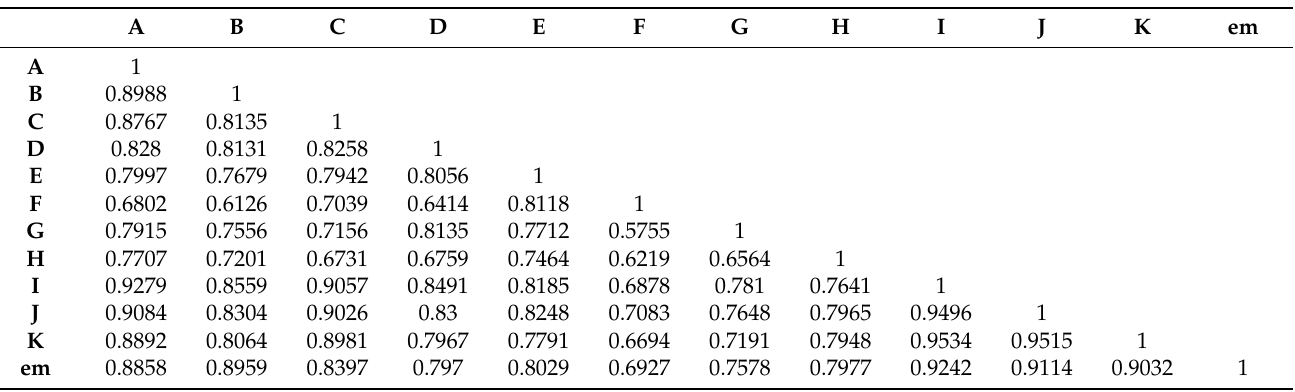
Table A3. Winter time (November-April) PM2.5 correlations between monitoring